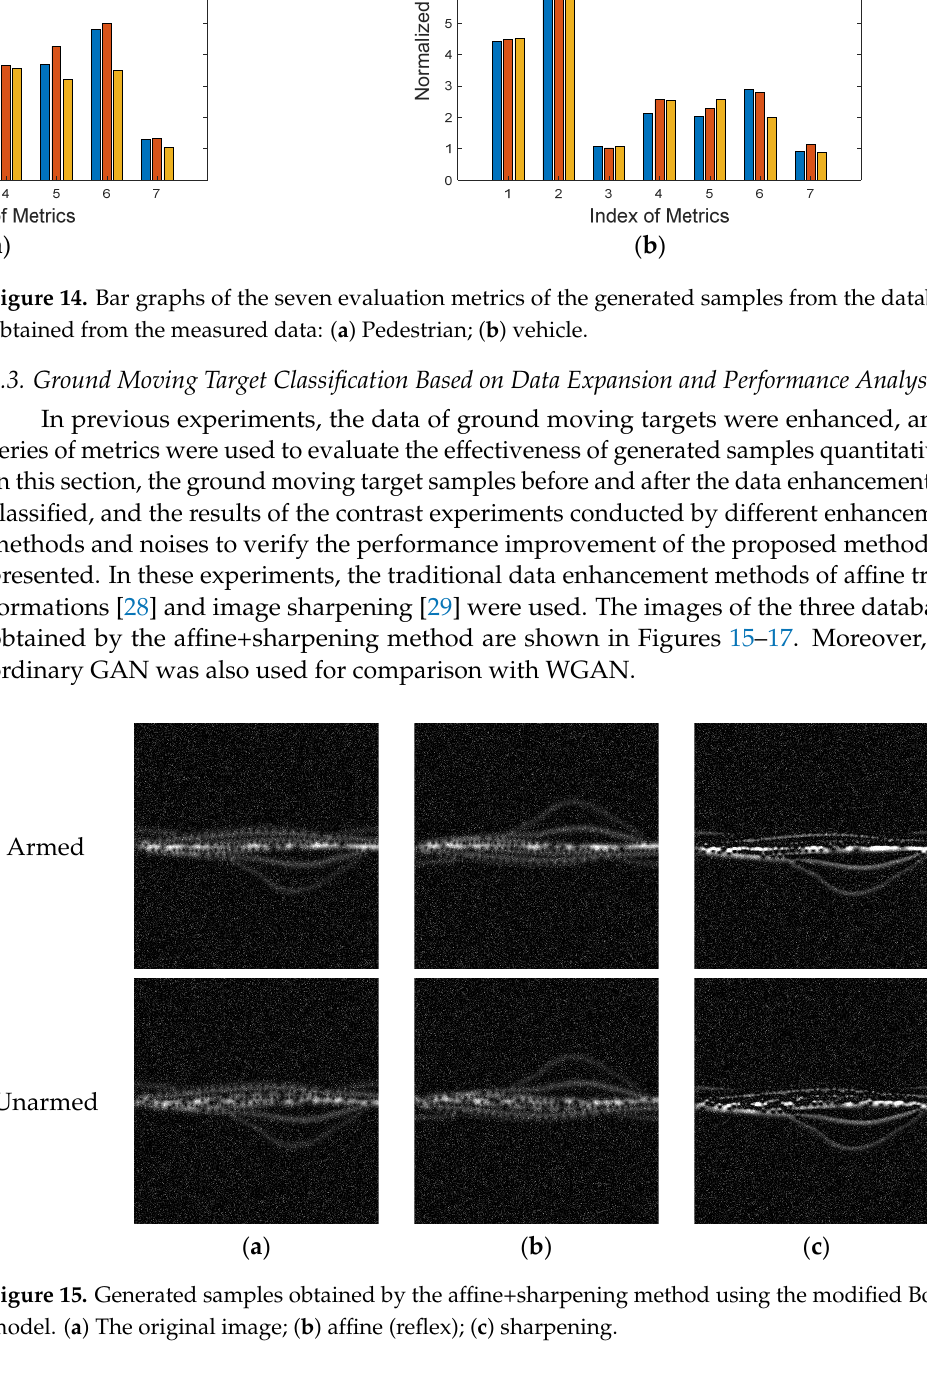
( c ) Figure 16. Generated samples obtained by the affine+sharpening method from the MOCAP and EM data. ( a ) The original image; ( b ) affine (reflex); ( c ) sharpening.